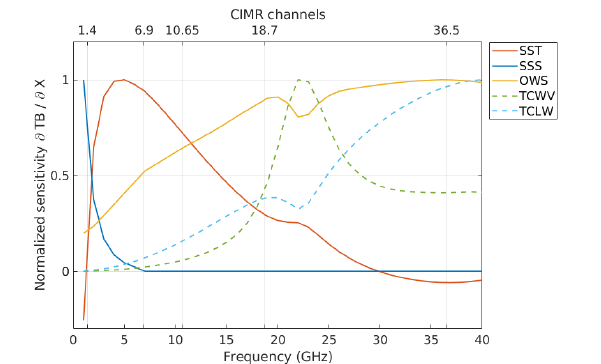
Figure 2. Normalized sensitivities of the satellite measurements to surface parameters (solid lines) and atmospheric parameters (dashed lines) as a function of frequency at 55 ◦ incidence angle. For the ocean and atmospheric parameters, the mid-latitude conditions are used. The selected central frequencies for CIMR are indicated (vertical bars). Variations of the sensitivities due to the variations of the surface and atmospheric parameters are shown in Fig.